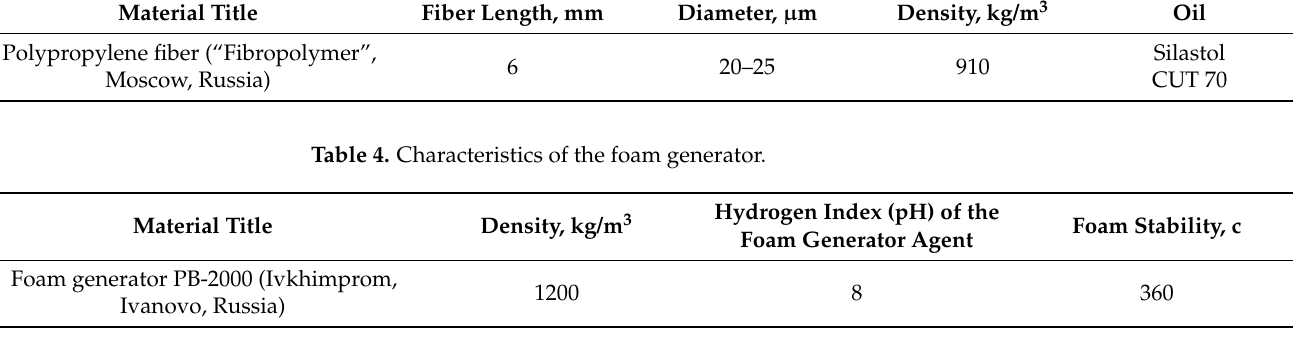
Table 3. Characteristics of polypropylene fiber.